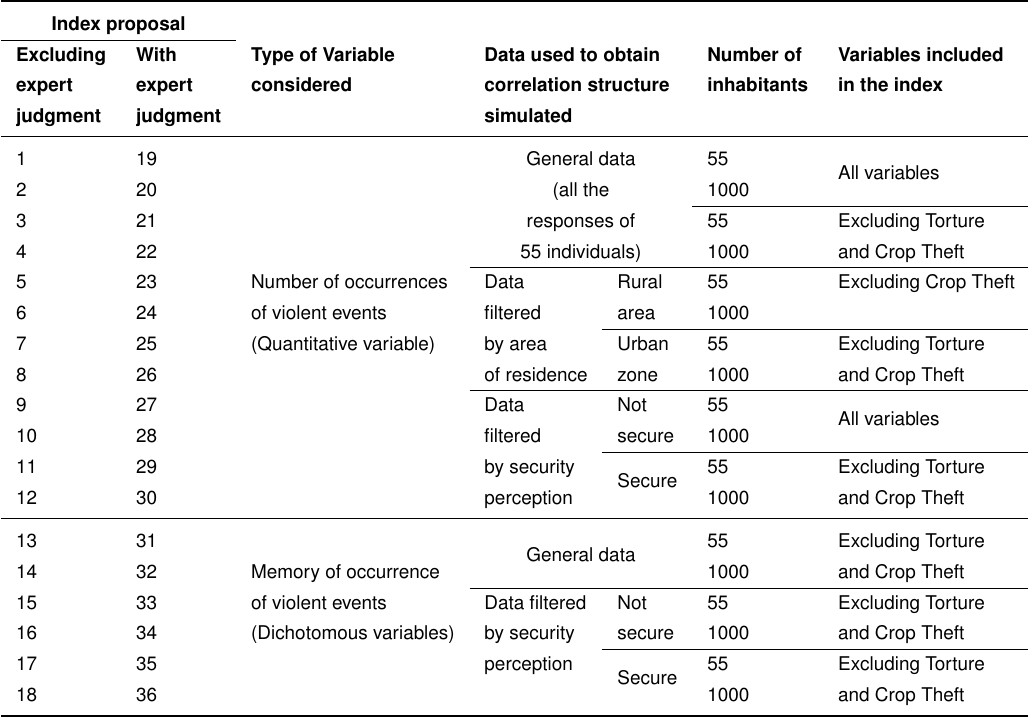
Table 2. Considered scenarios for the construction of the HSI according to expert judgment, type of variable, survey data, and simulated sample